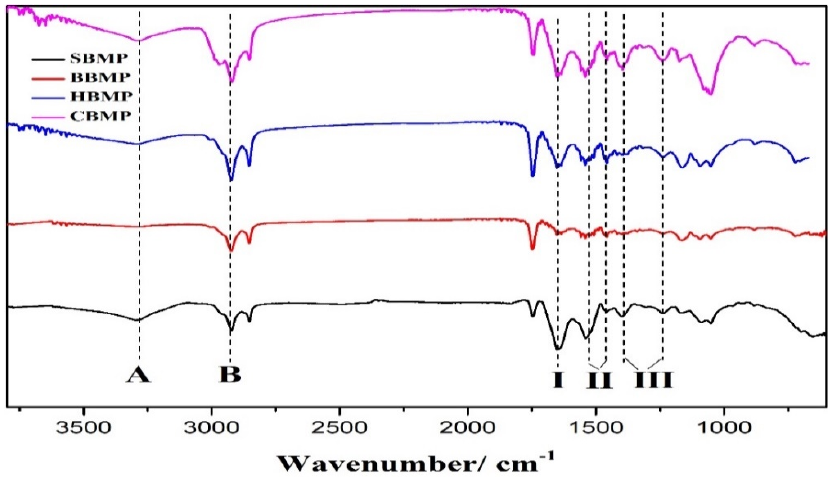
Figure 2. FT ‐ IR spectra of four types of BMP from water extract. (A, B, I, II, III indicate amide A, B, I, II, III band). Table 5. Peak positions and assignment of BBM in FT ‐ IR spectra.